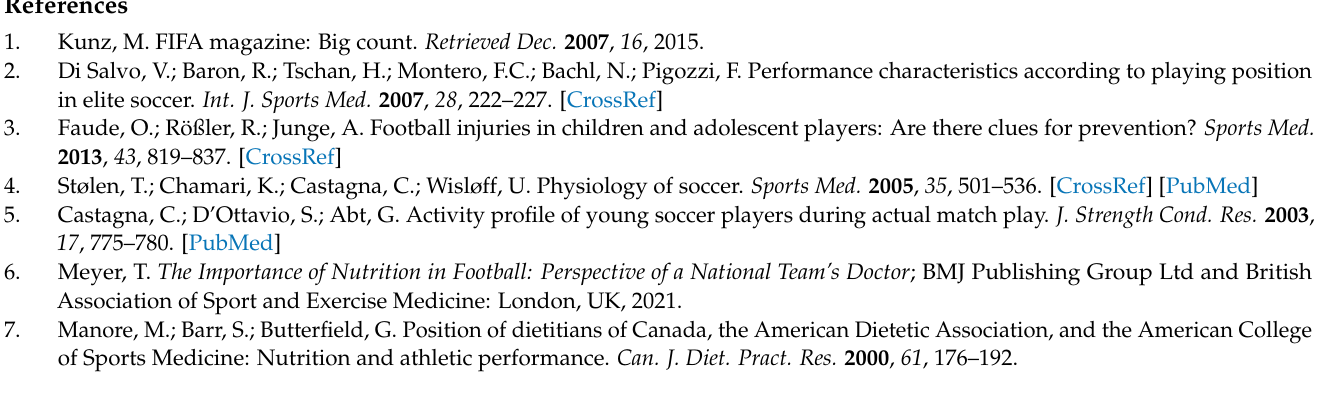
group. Table S2. Anthropometric parameters by field position in the 10–12 years group. Table S3. Mediterranean diet quality index in the different groups. Table S4. Non-parametric Spearman’s correlations. Table S5. Details of the responses for each item of the KIDMED test by groups. Table S6. Main beverages consume and use of supplements in the total